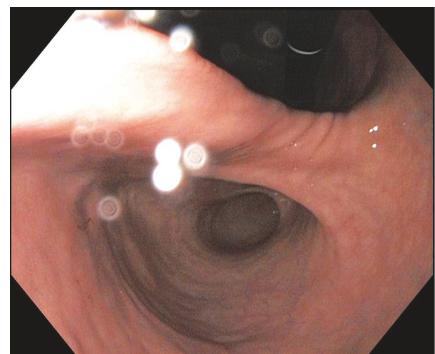
Figure 4: Retroflexed endoscopic view of the lesser curvature of the body of the stomach, antrum, and fundus, depicting the deeply J-shape anatomy of the stomach.